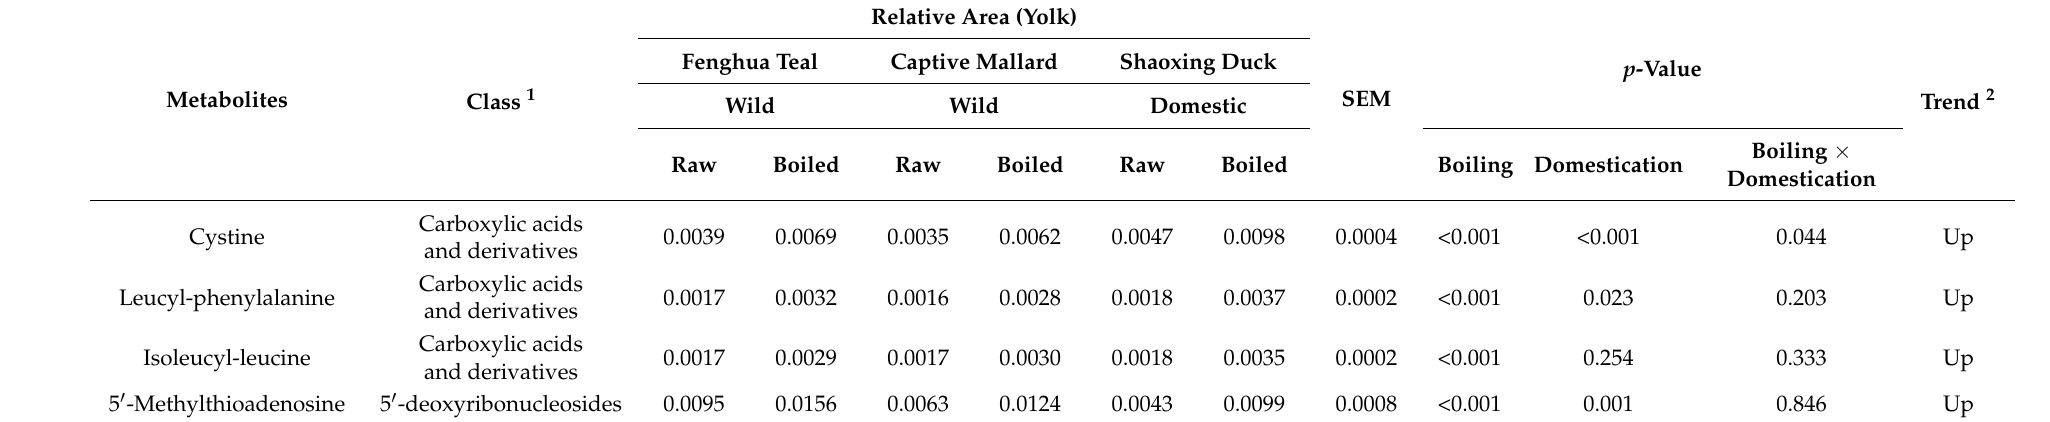
Table 2. Metabolites with boiling-induced